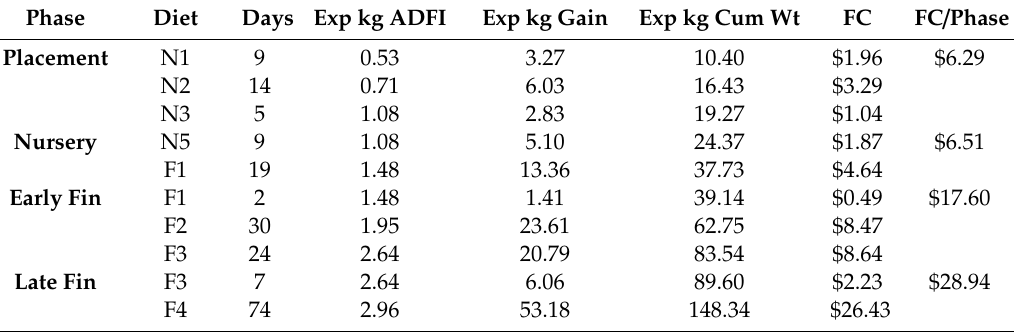
Table 4. For each cluster, feed costs per pig were parsed into four phases based on diet assumptions in Table 2. These values are for cluster